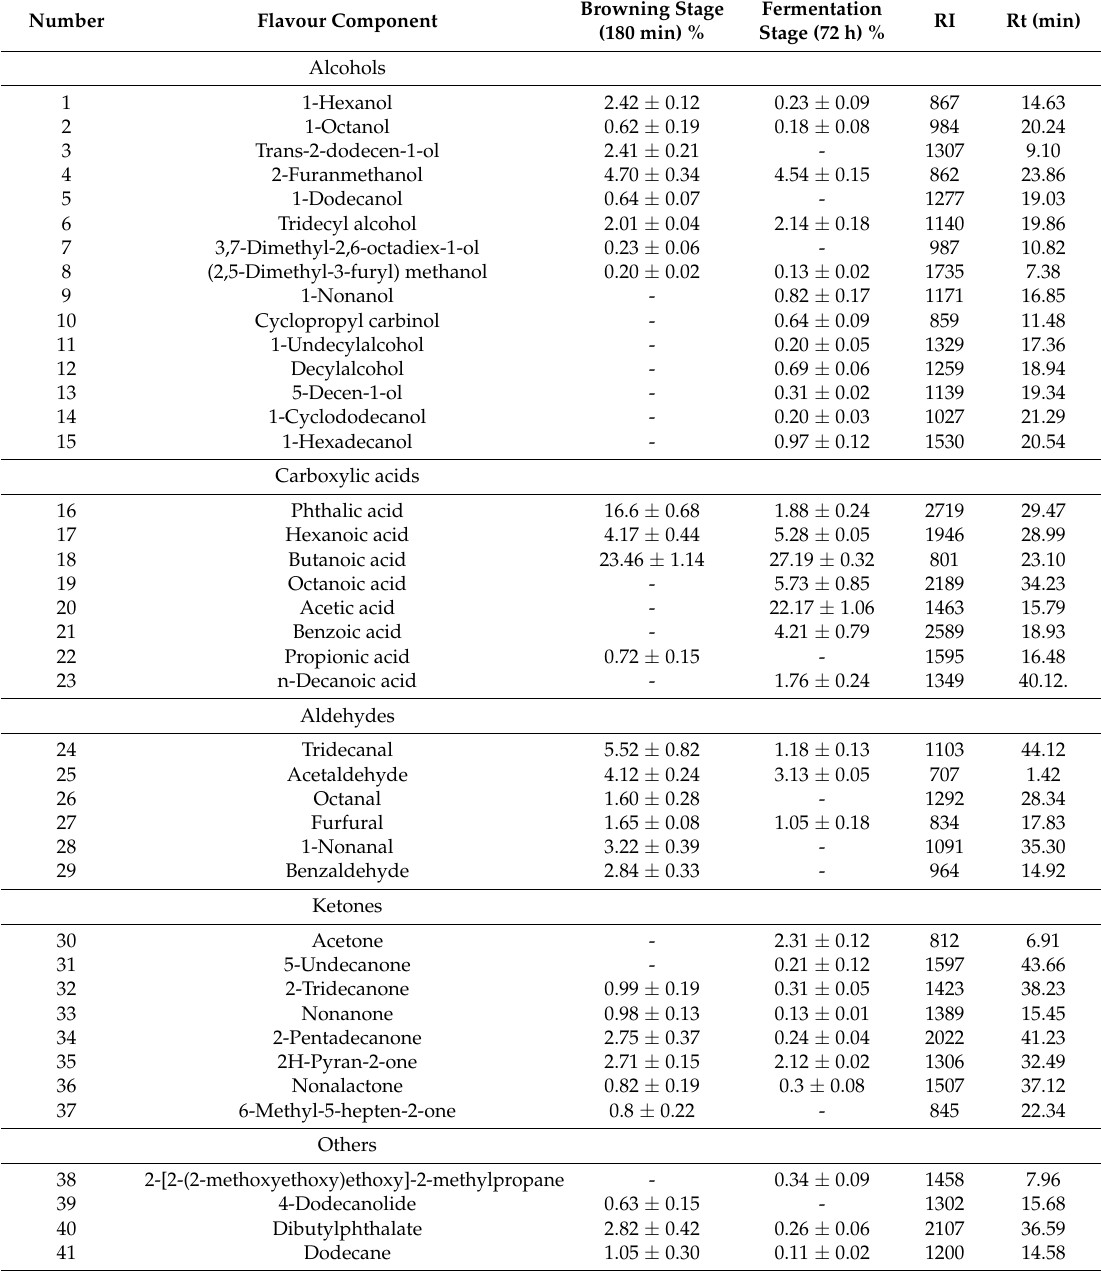
Table 2. Comparisons between flavour component levels during browning (180 min) and fermentation (72 h) of brown fermented milk